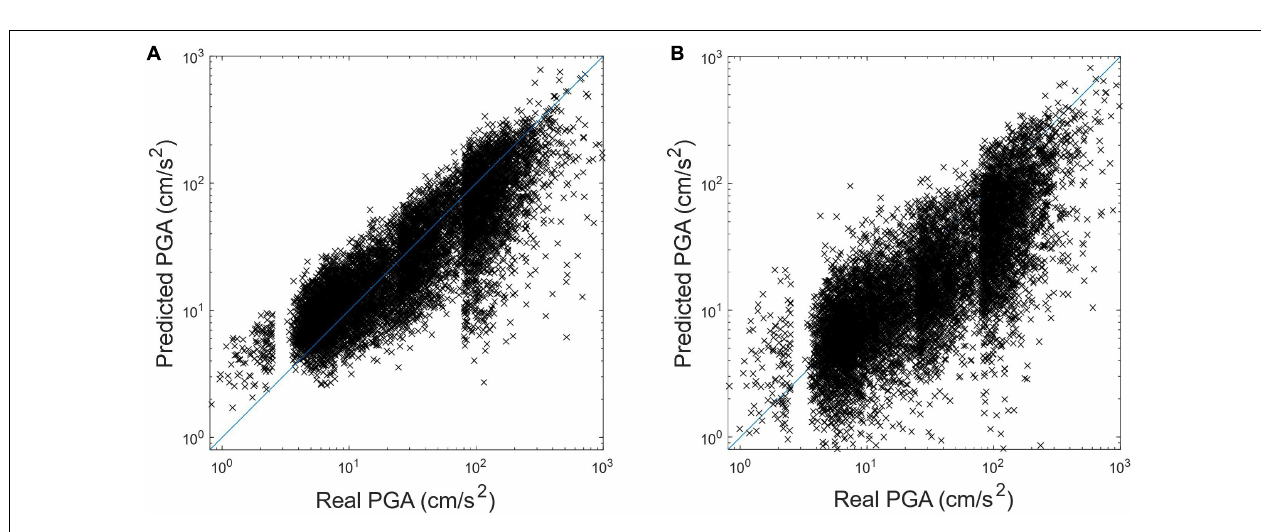
FIGURE 10 | The predicted PGA distribution of the 10,000 T-data earthquakes using (A) the SVR approach in Hsu et al. (2013), and (B) the GMPE-based